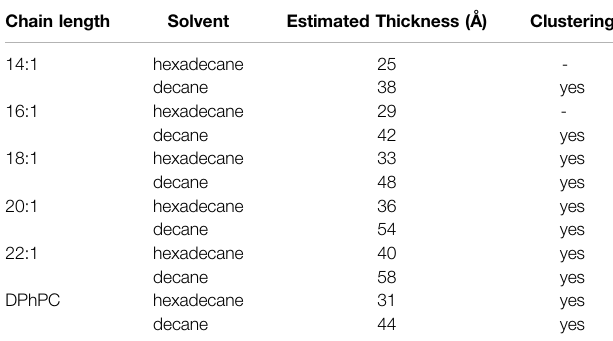
clusteringexperiments.Thetwoshortestchainlengths(14:1and16:1)didnot producestablebilayers,sonoresultshavebeenobtained.Forallotherconditions, clustering was observed. Chain